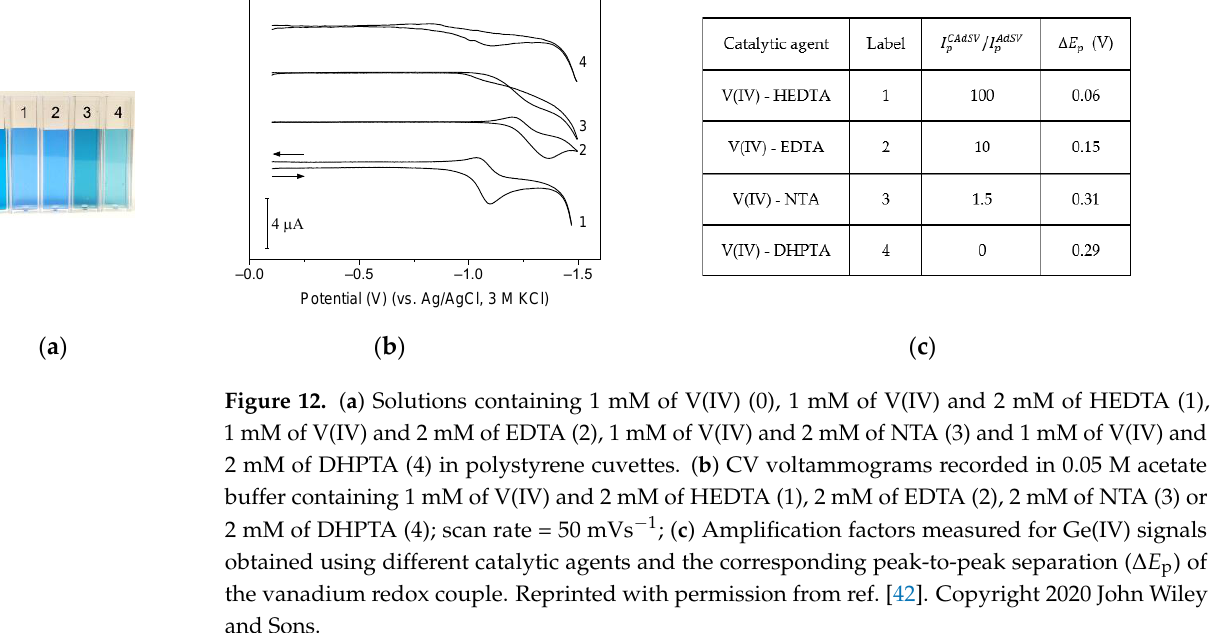
Figure 12. ( a ) Solutions containing 1 mM of V(IV) (0), 1 mM of V(IV) and 2 mM of HEDTA (1), 1 mM of V(IV) and 2 mM of EDTA (2), 1 mM of V(IV) and 2 mM of NTA (3) and 1 mM of V(IV) and 2 mM of DHPTA (4) in polystyrene cuvettes. ( b ) CV voltammograms recorded in 0.05 M acetate buffer containing 1 mM of V(IV) and 2 mM of HEDTA (1), 2 mM of EDTA (2), 2 mM of NTA (3) or 2 mM of DHPTA (4); scan rate = 50 mVs −1 ; ( c ) Amplification factors measured for Ge(IV) signals obtained using different catalytic agents and the corresponding peak-to-peak separation (Δ E p ) of the vanadium redox couple. Reprinted with permission from ref. [42]. Copyright 2020 John Wiley and Sons.